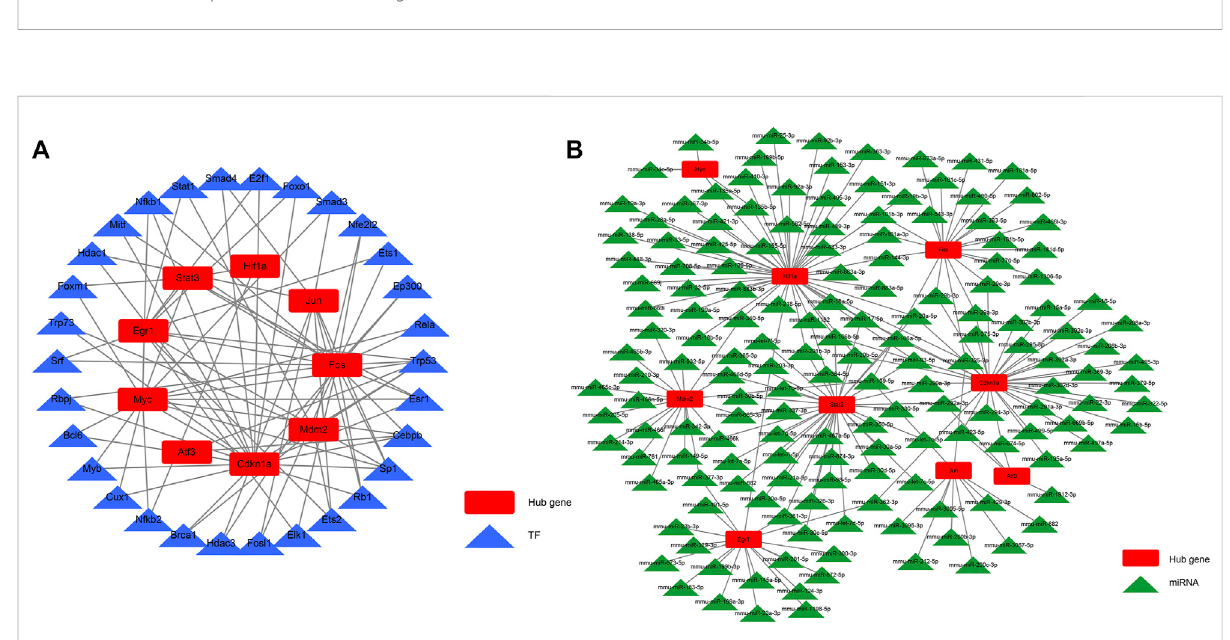
FIGURE 8 TF – hub gene interaction network and miRNA – hub gene interaction network. (A) TF – hub gene network; (B) miRNA – hub gene network.